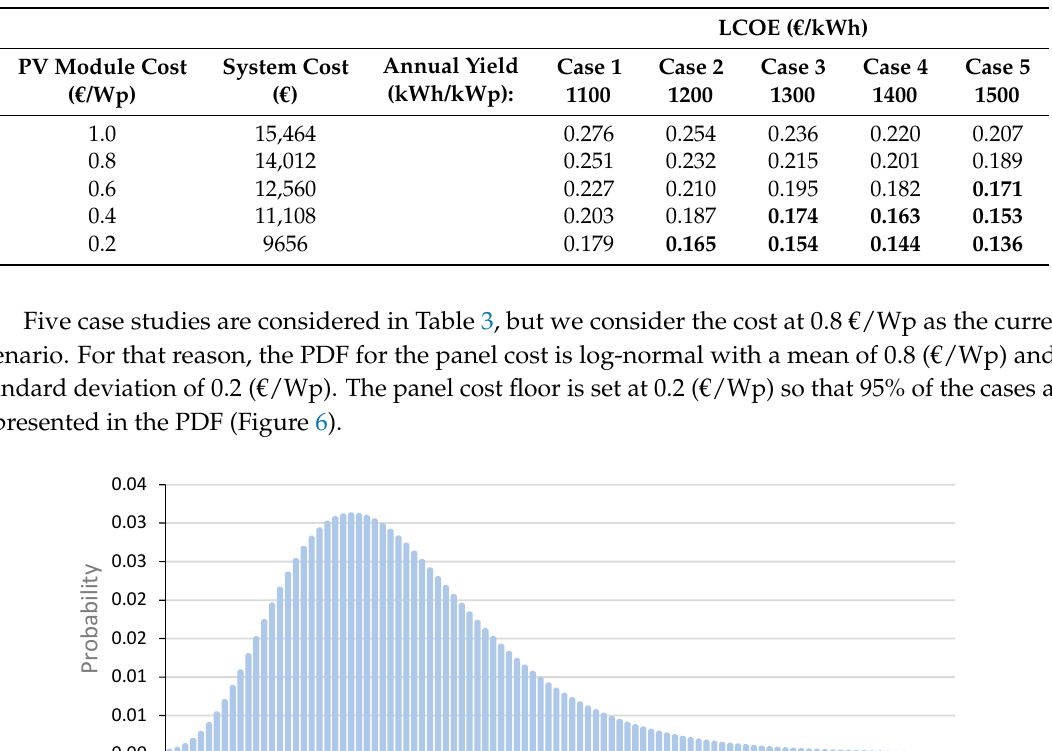
Figure 7. Histogram of the LCOE calculated with the Monte Carlo method for a 5 kW system.